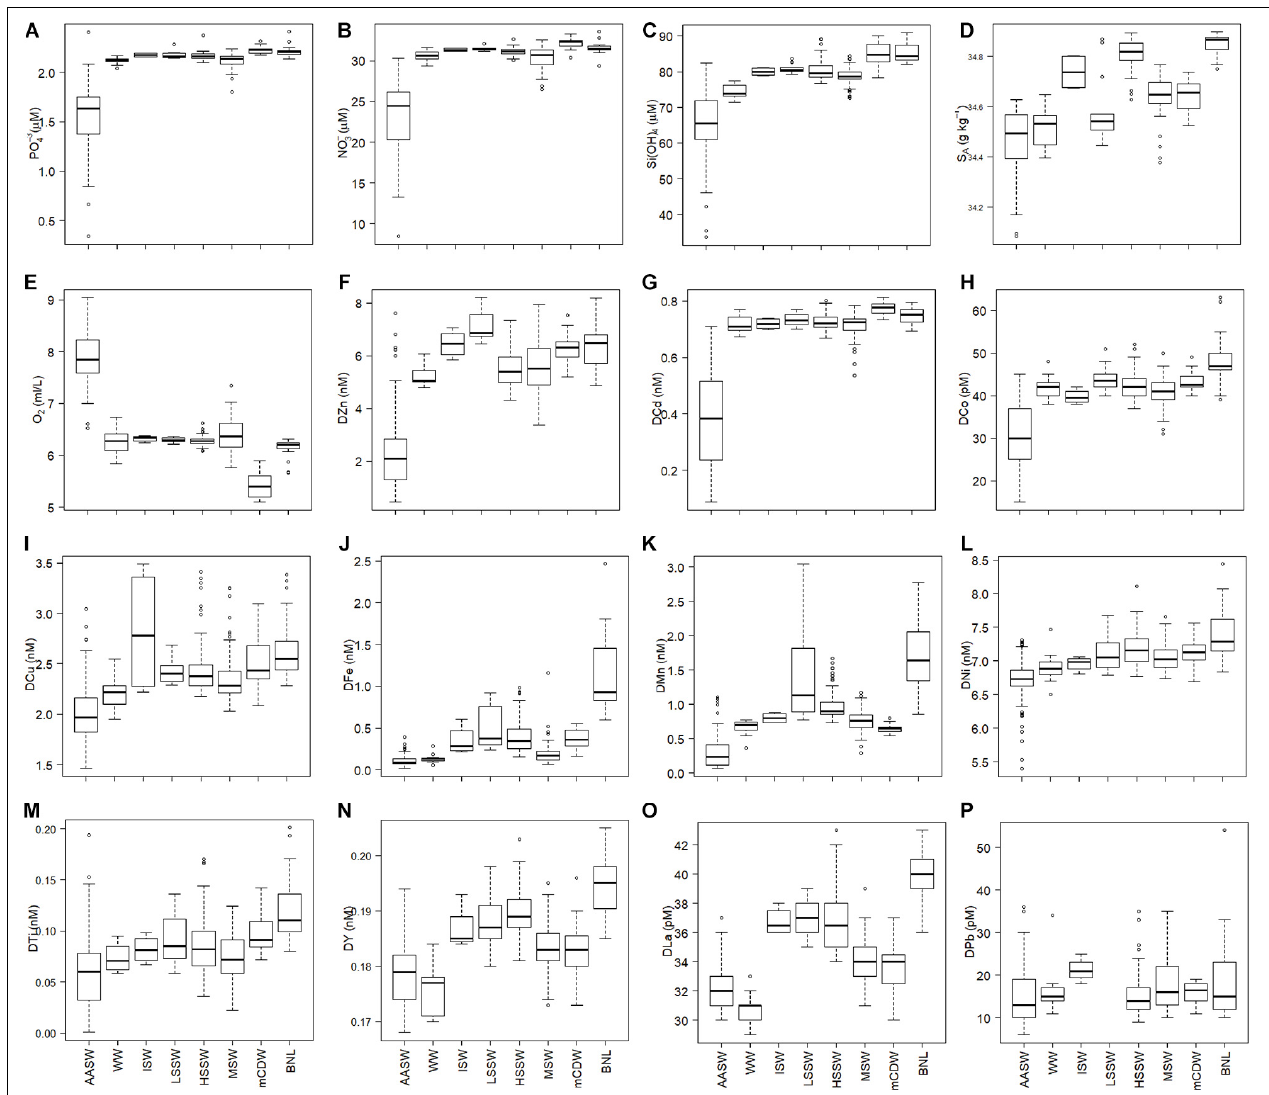
FIGURE 3 | Boxplots of the dissolved concentrations of macro-nutrients, oxygen, and trace metals of all stations per water mass as defined by Tomczak and Godfrey (2001) and Orsi and Wiederwohl (2009) (see text). (A–C) are in µ M, (D) is in g kg − 1 , (E) is in ml/L, dissolved metals are in nM, with the exception of DCo, DLa, and DPb which are in pM (H,O,P) . (A:) PO 43 − , (B) NO 3 − , (C) Si(OH) 4 , (D) absolute salinity, (E) oxygen, (F) DZn, (G) DCd, (H) DCo, (I) DCu, (J) DFe, (K) DMn, (L) DNi, (M) DTi, (N) DY, (O) DLa, (P) DPb. The median values are indicated by the thick horizontal line in the boxes, which contain the first and third quartiles, whereas the whiskers indicate the range excluding outliers. Circles are outliers ( > 1.5 interquartile range from the box, Teetor, 2011). The figures are made using the software package